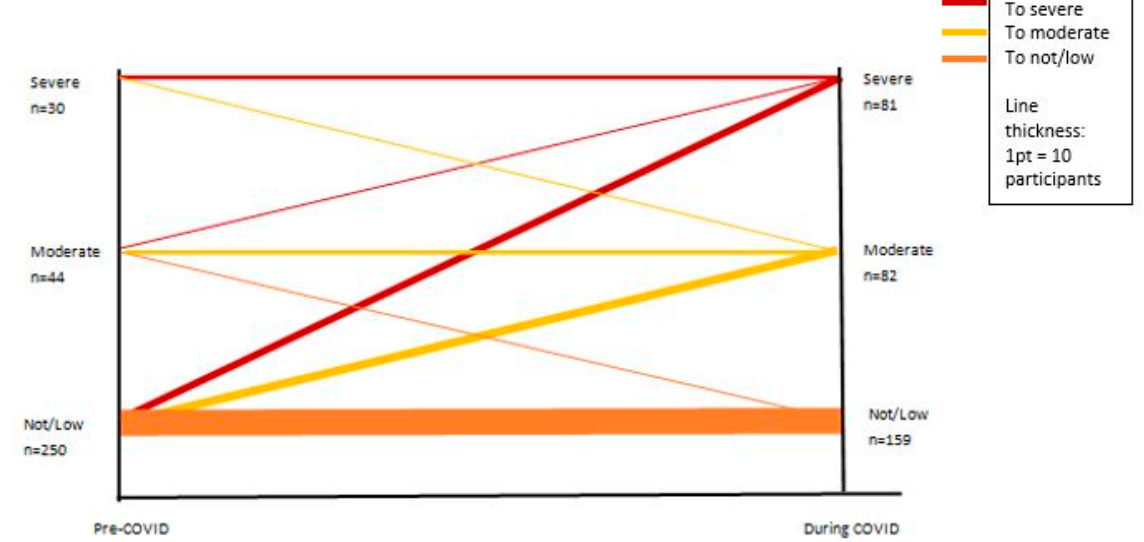
Figure 2. Trajectories of loneliness pre- and during COVID-19 for carers of people living with an intellectual disability ( n = 324).